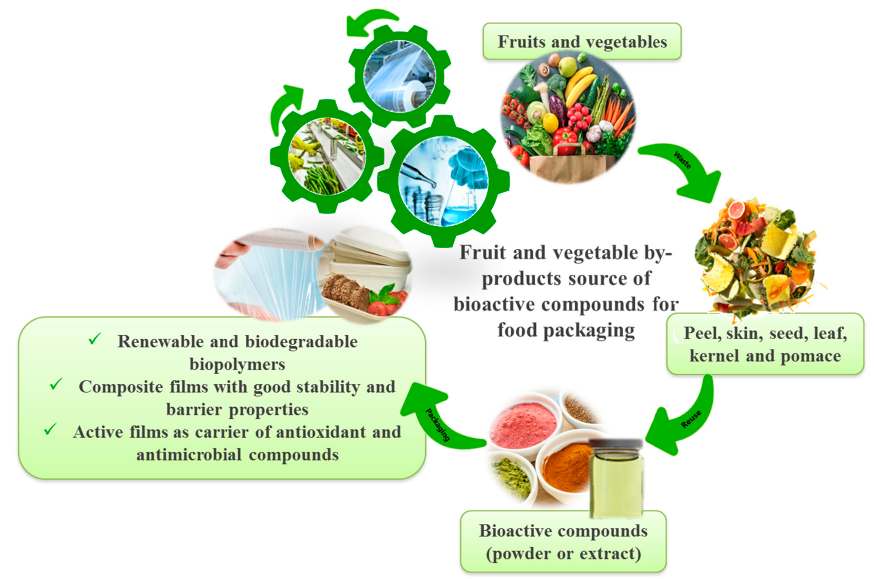
Figure 3. The potential application of agro-industrial by products to packaging materials.